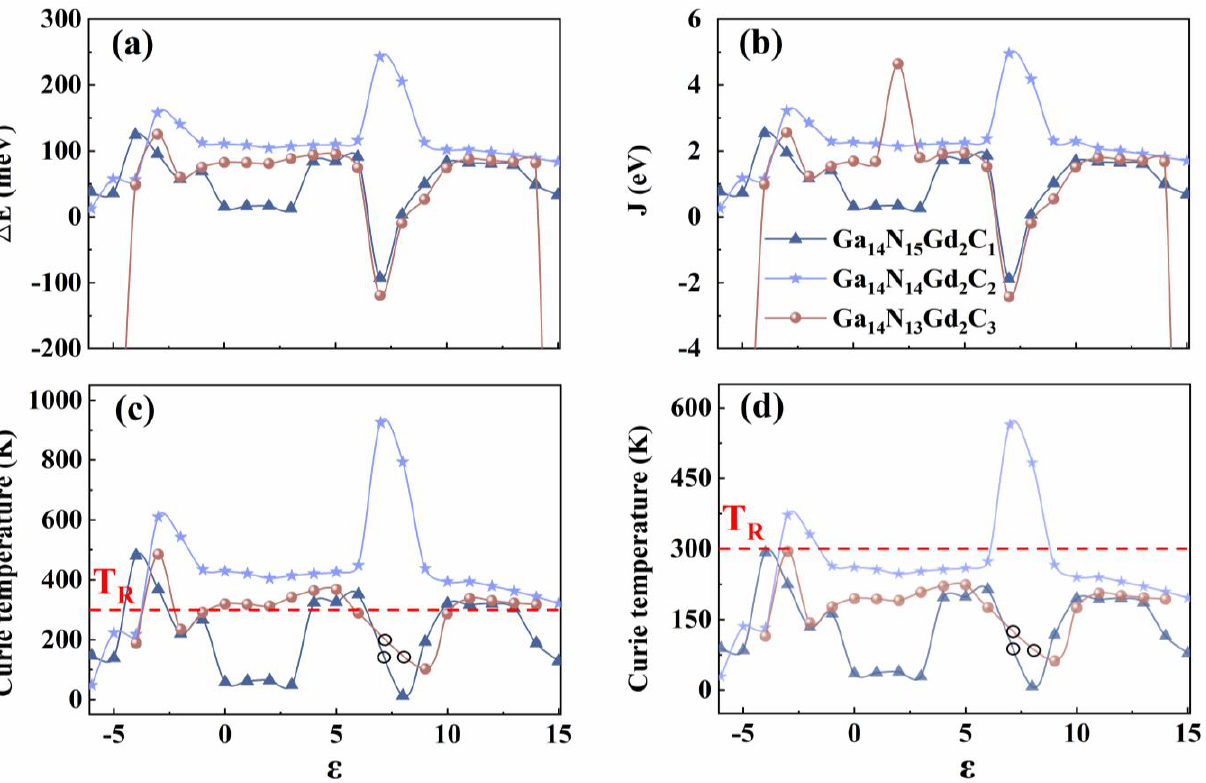
Figure 6. ( a ) Energy difference ( △ E), ( b ) the magnetic coupling parameter (J), ( c ) T CFMA and ( d ) T C . The dark blue (triangle), light blue (pentagram) and brown (circle) lines in the diagram represent the Ga 14 N 15 Gd 2 C 1 , Ga 14 N 14 Gd 2 C 2 and Ga 14 N 13 Gd 2 C 3 monolayers, respectively. The red dashed lines in the last two graphs indicate T R . The black circles in the last two figures indicate this position as an AFM state without T C .